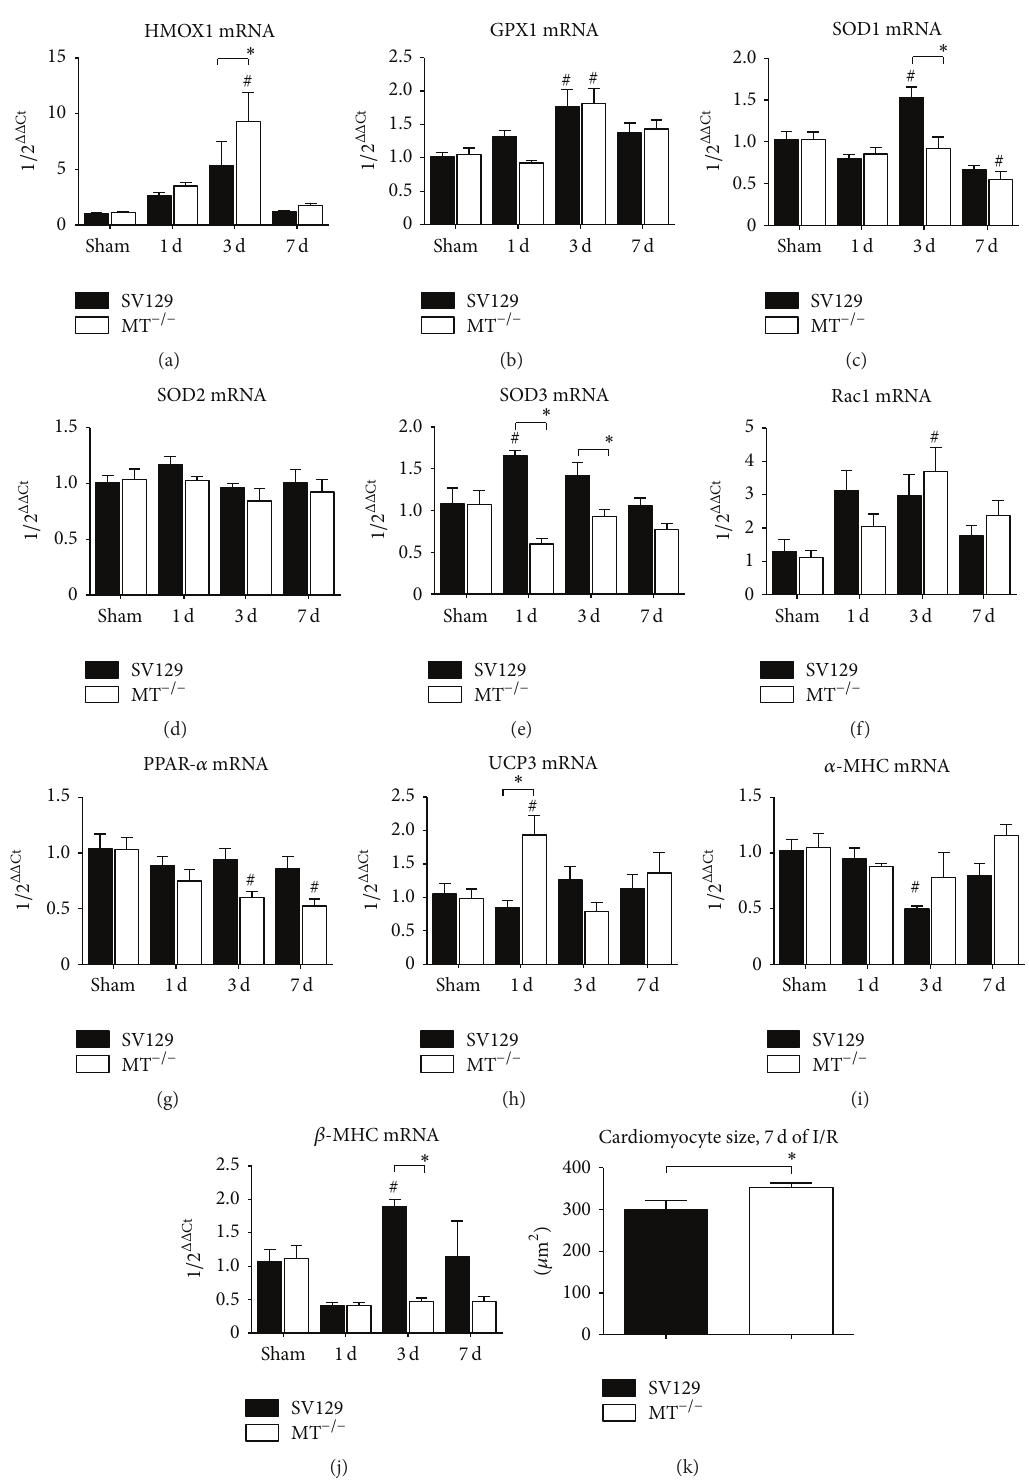
Figure 3: Impaired antioxidative control and maladaptation of contractile elements in MT −/− -hearts. RT-qPCR showing mRNA expression of (a) heme oxygenase (HMOX)1, (b) glutathione peroxidase (GPX)1, (c) superoxide dismutase (SOD)1, (d) SOD2, (e) SOD3, (f) Ras-related C3 botulinum toxin substrate (Rac)1, (g) peroxisome proliferator-activated receptor (PPAR)- 𝛼 , (h) uncoupling protein (UCP) 3, (i) myosin heavy chain (MHC) isoform 𝛼 , and (j) 𝛽 -MHC isoform. (k) Quantification of cardiomyocyte size by area planimetry on collagen stained slides after 7 days of I / R. 𝑛 = 8–10/group; RT-qPCR using Taqman, mRNA expression is related to shams and GAPDH using comparative ΔΔ Ct-method; ∗ indicates P ≤ 0.05 between the genotypes; # indicates P ≤ 0.05 versus respective